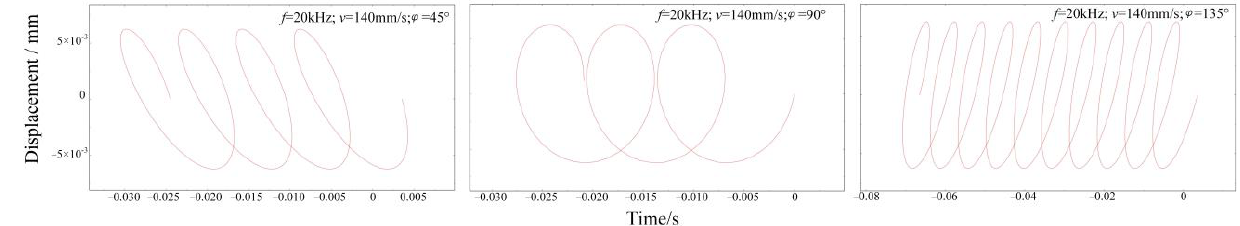
Figure 5. Simulation of cutting path.